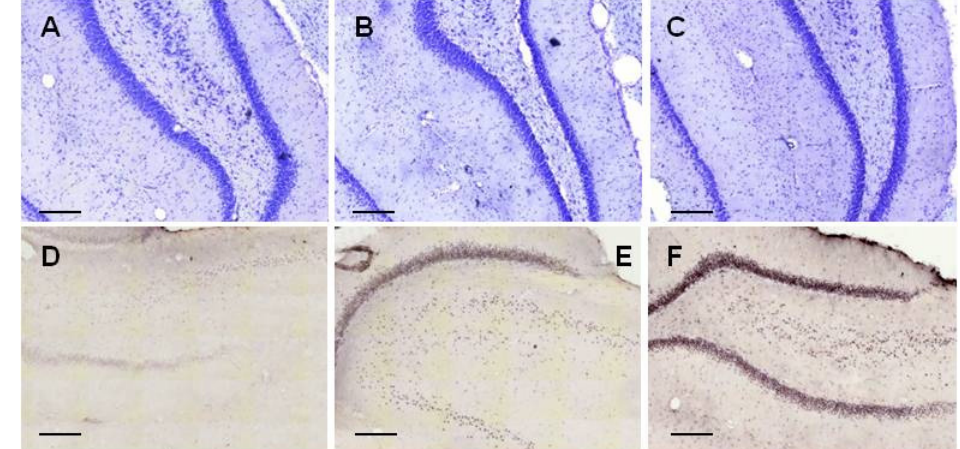
Figure 5. Representative coronal examples of hippocampcal sections stained with cresyl-violet (first row) to show the presence of neuron number (first row) and with tau-antibody to show the presence of abnormally aggregated NFTs (second row). ( A , D ): control group; ( B , E ): 24 h aggregated 25 μ M amyloid treated group; ( C , F ): 168 h aggregated 25 μ M amyloid treated group. Scale bar: 200 μ m.